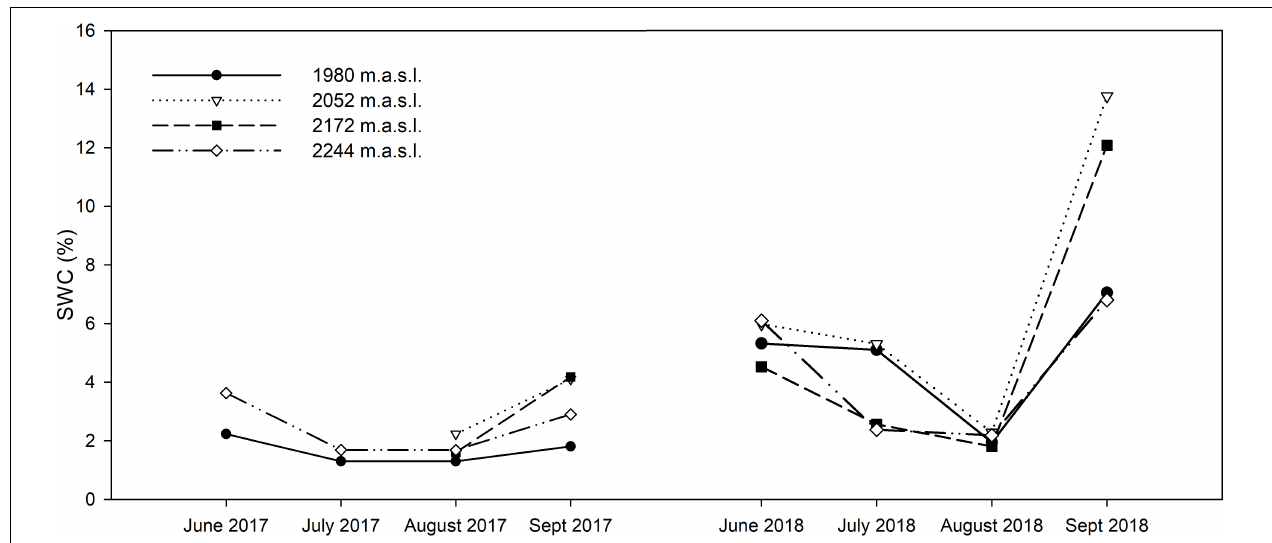
FIGURE 1 | Seasonal variation in SWC along the studied altitudinal gradient through the active growing season of vegetation in the study site. Data corresponds to in-site measurements on both years of study (2017,